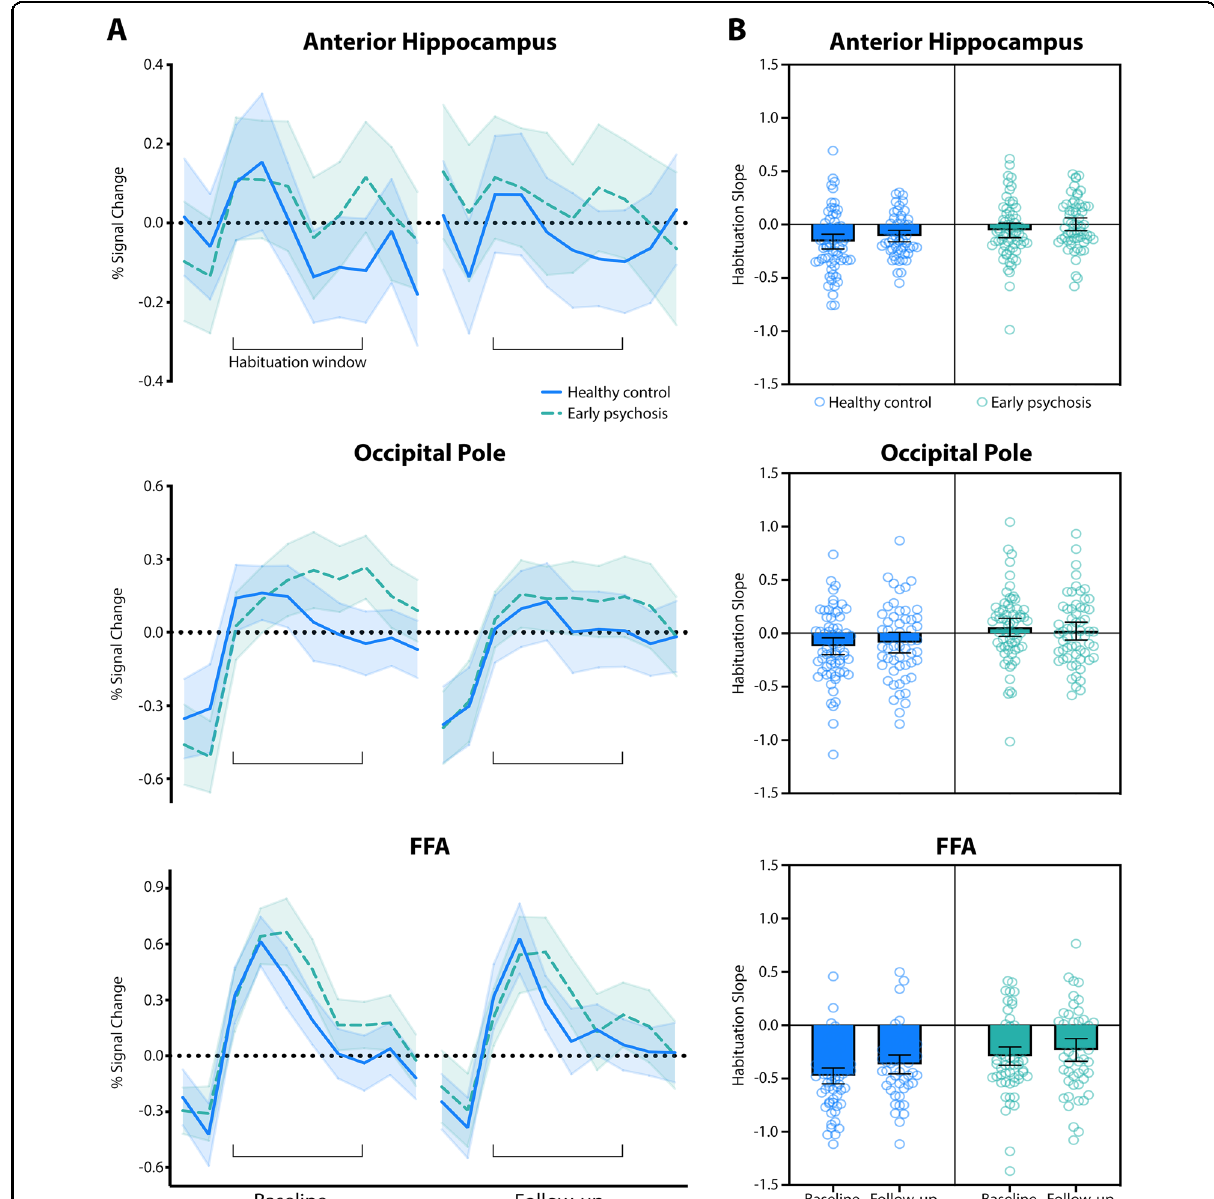
Fig. 2 Neural habituation to repeated objects at baseline and 2-year follow-up by group. Mean fMRI signal for the fi rst 20 s of the repeated objects task is shown for each visit by ROI ( A ). Habituation slopes were calculated over a 10 s habituation window, with more negative slopes indicating greater habituation. The healthy control group showed negative habituation slopes across ROIs ( B ). The early psychosis group showed negative habituation slopes in only the FFA, and habituation slopes in all ROIs were smaller than in the healthy control group. Habituation slopes in both groups were consistent over time. Bars show the mean habituation slope by group ( B ); shaded areas ( A ); and error bars ( B ) indicate the 95% con fi dence